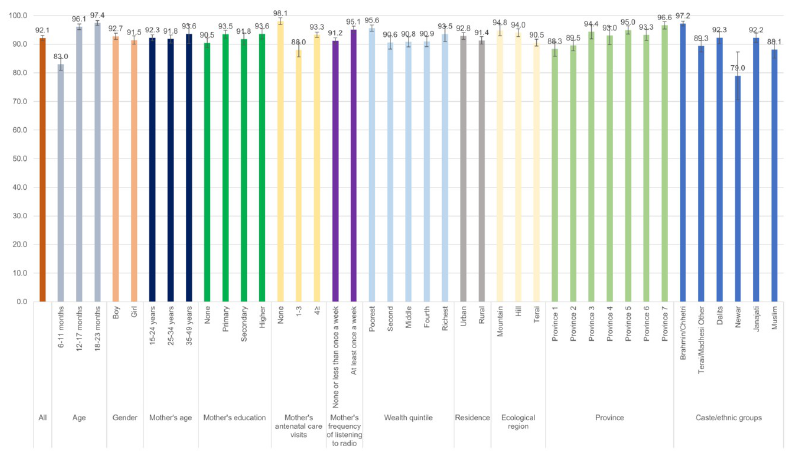
Fig 1. Percentage of Nepalese children aged 6 to 23 months consuming grains, roots and tubers by sociodemographic factors.